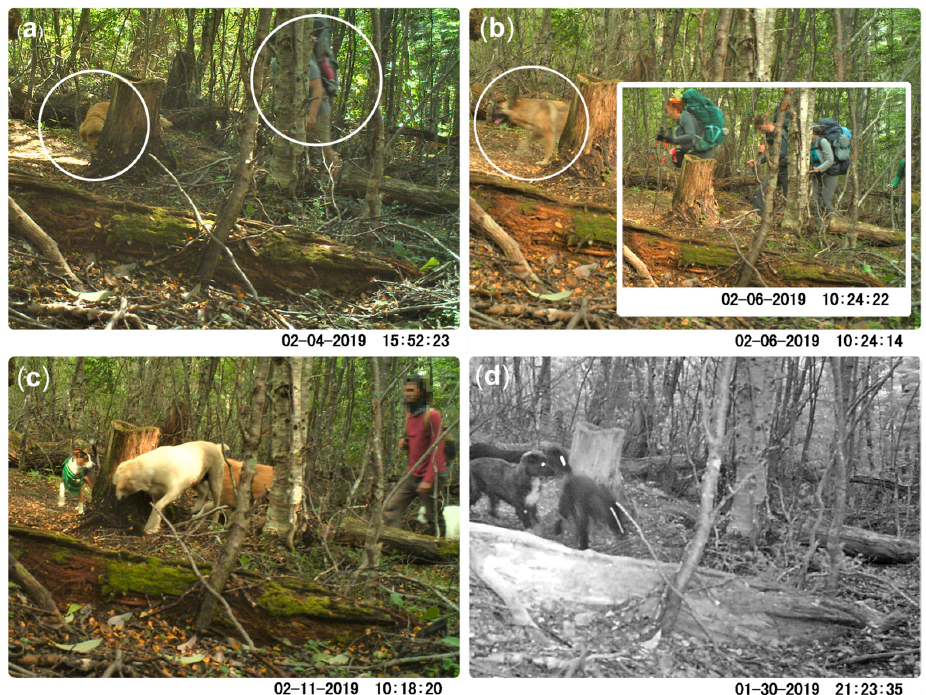
Figure 4. Photographs (cutout of relevant section) of camera-trap in Trail No. 1 in southern Chile during summer 2019. ( a ) Free-ranging dog and tourist using large backpack; ( b ) free-ranging dog photographed 8 s before a group of four tourists using large backpacks (inset); ( c ) four free-ranging dogs with tourist on daily excursion, and ( d ) three free-ranging unaccompanied dogs photographed 1:56 h after last person and 11:51 h before next person.